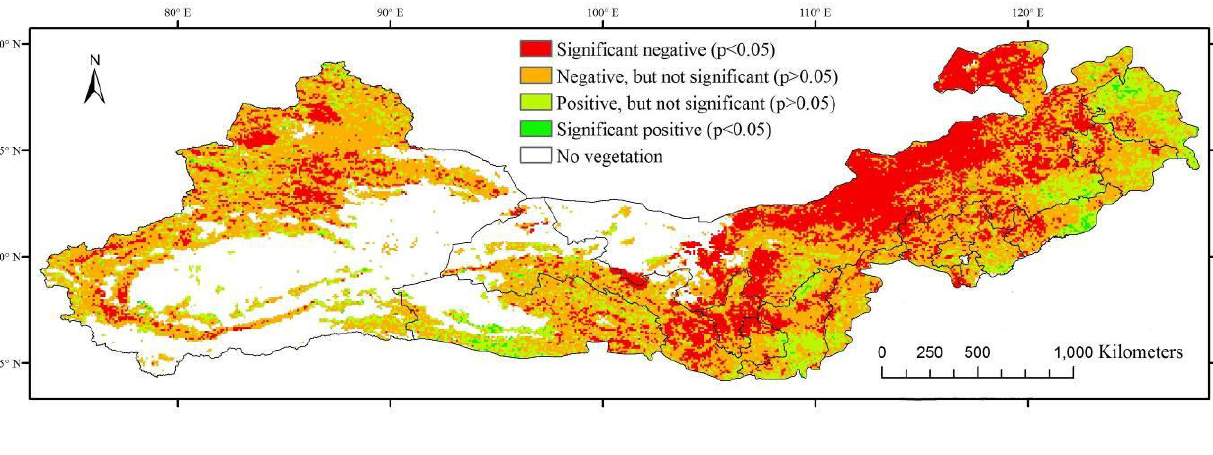
Figure 6. Correlations between growing-season NDVI and corresponding soil moisture ( I m ) from 1982 to 2011. Correlations were considered significant for p < 0.05. Red areas represent negative relationships, and green areas represent positive